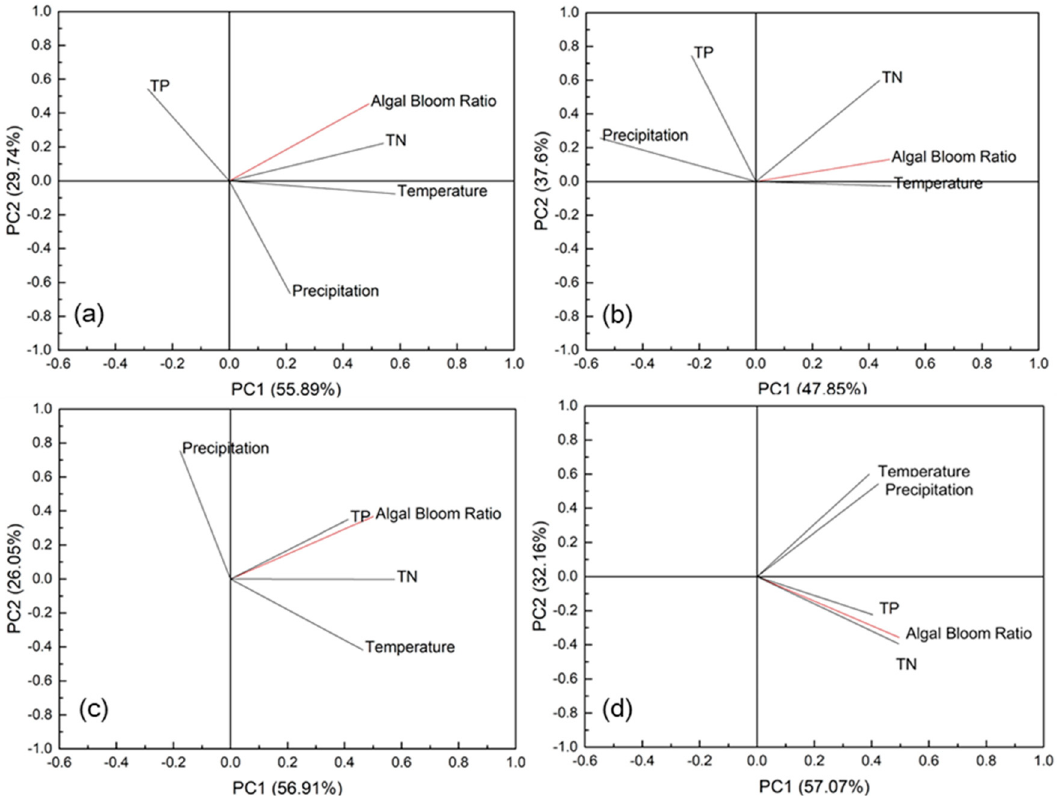
Figure 16. PCA ordination diagram of interannual algal blooms in Dongting Lake. ( a ) 2001–2003; ( b ) 2003–2008; ( c ) 2008–2013; and ( d ) 2013–2017. (The bloom ratio is the ratio of the annual mean algal bloom area to the water surface area in the same year).